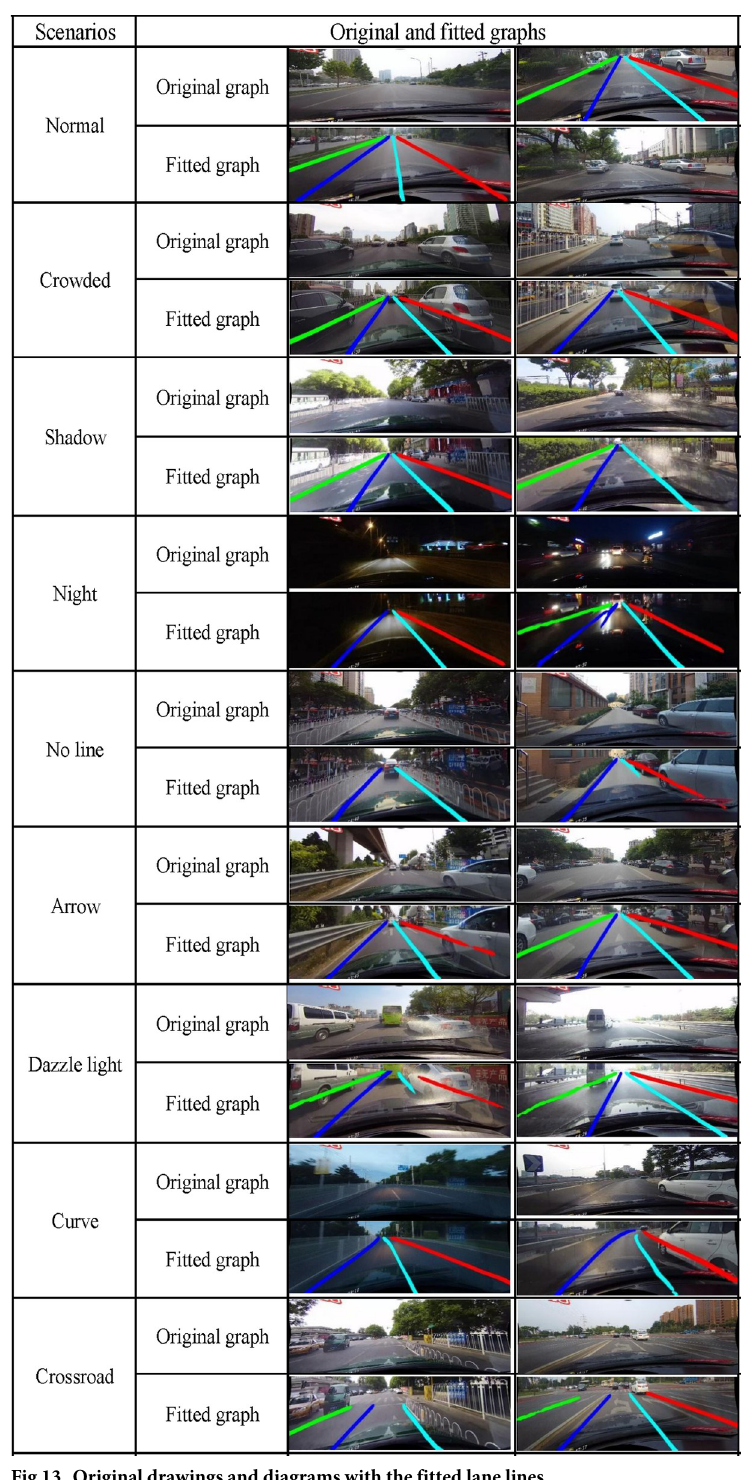
Fig 13. Original drawings and diagrams with the fitted lane